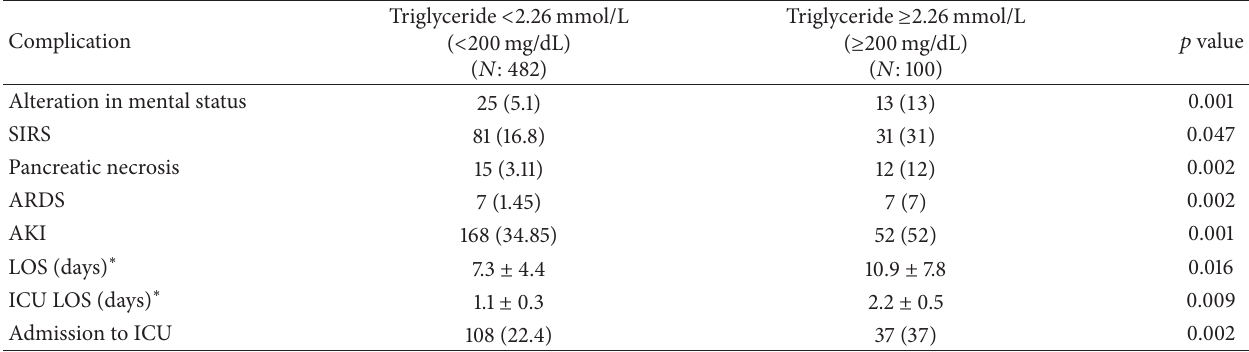
Table 4: Multivariate analysis showing association of triglyceride level with complications after adjusting for advanced age, sex, obesity, and diabetic status.